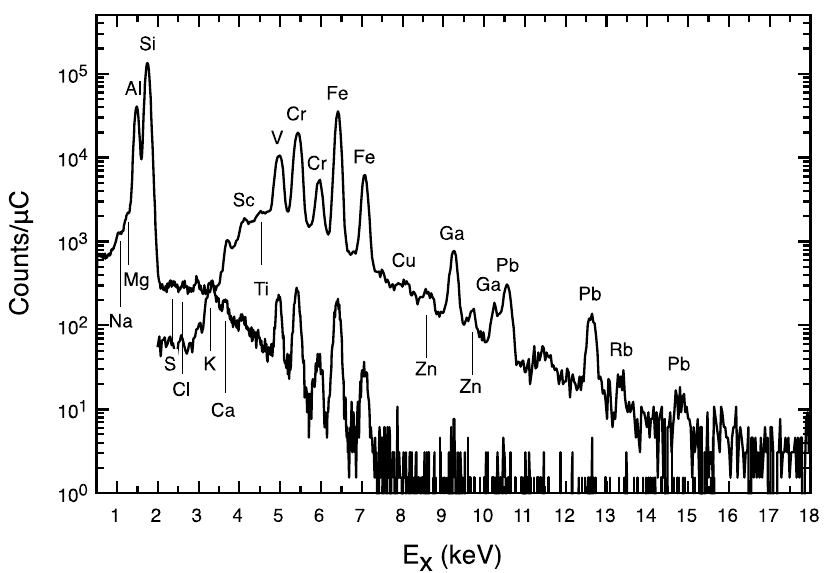
Figure 1. PIXE spectra of an emerald obtained with 3 MeV protons, collected simultaneously with a small area SDD for low-Z elements (Na-Ca) and a large area SDD with 450 mm Mylar foil as absorber for mid- and high-Z elements (Sc-Pb). The spectra are normalised by the proton beam charge accumulated during the measurement.